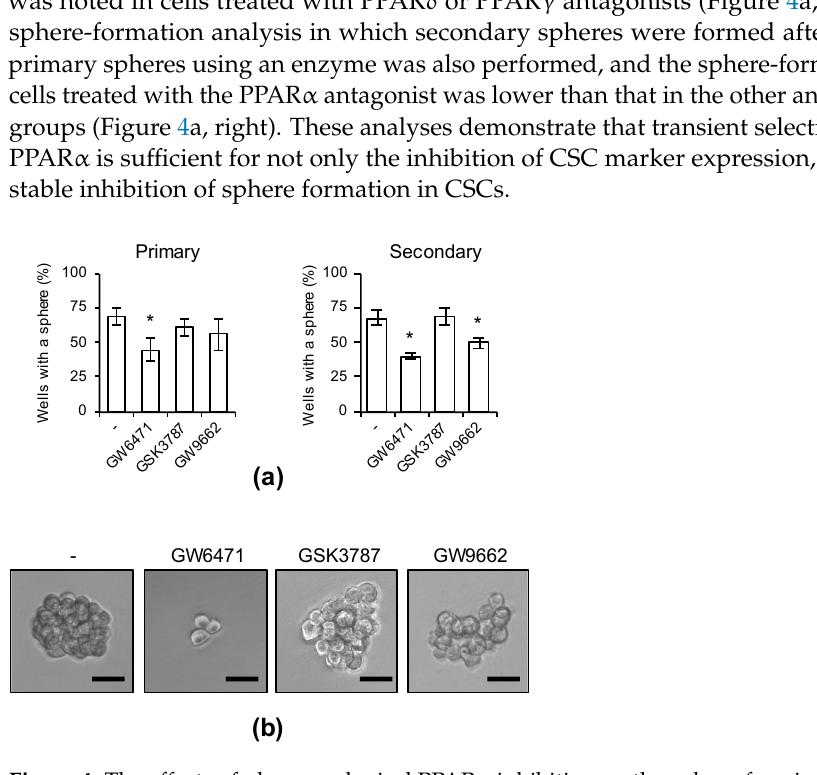
Figure 4. The effects of pharmacological PPAR α inhibition on the sphere-forming ability. PANC-1 CSCs were treated with 5 µ M PPAR antagonists for 10 days. After washing out the drugs, cells were analyzed in the serial sphere-formation assay. ( a ) The graphs show the means ± SDs from three independent experiments. ( b ) Representative photographs of primary spheres are shown. Similar results were obtained from three independent biological replicates. Bar: 50 µ m. * p < 0.05 vs. control-treated cells by Dunnett’s